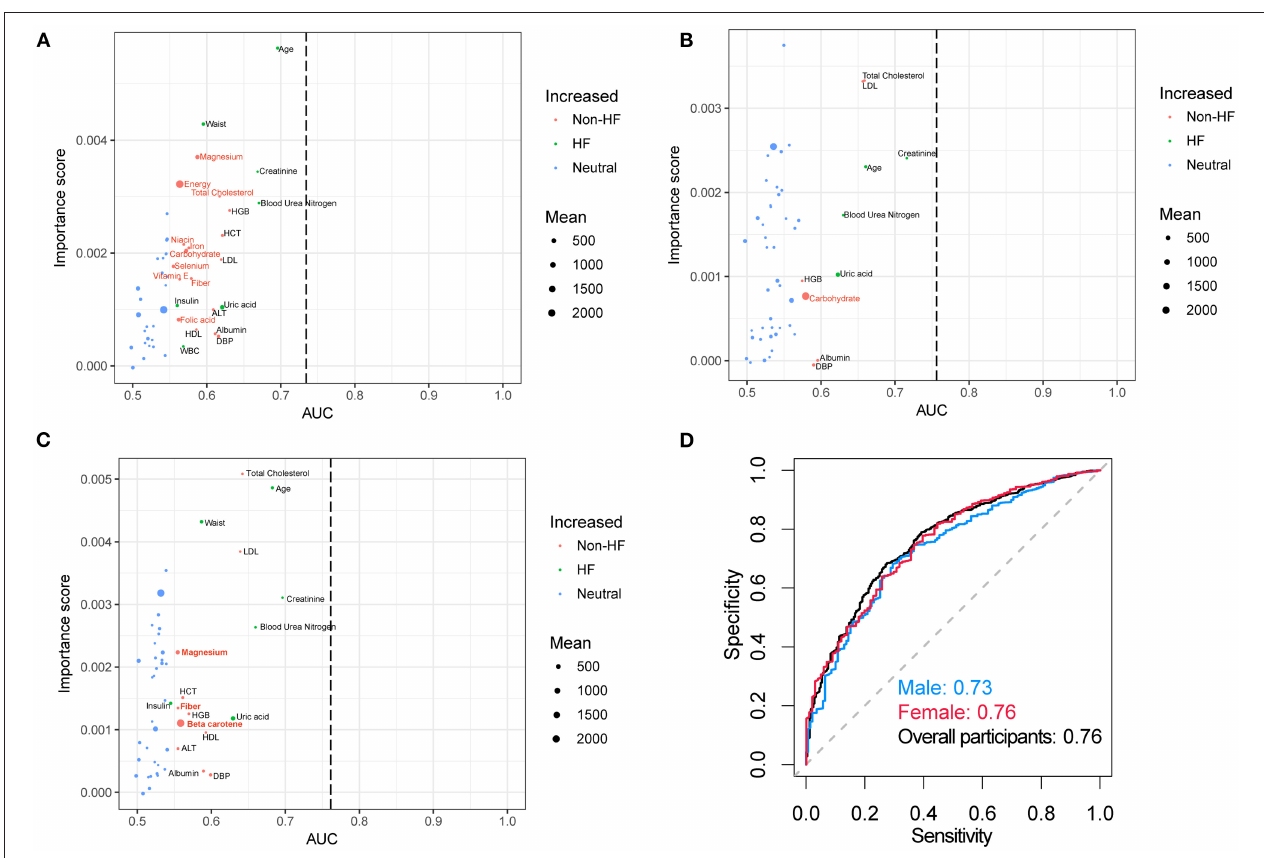
FIGURE 2 | Random forest analysis and AUC curves. Random forest analysis in (A) male, (B) female, (C) overall participants and their corresponding (D) AUC curves. The green (HF group) and red (non-HF group) nodes which were significantly different between these two groups denoted the important score in the construction of the random forest model. The AUC curves for the random forest models in separating HF and non-HF groups using the dietary information and laboratory examinations. The red font indicated the dietary indices. AUC, area under the